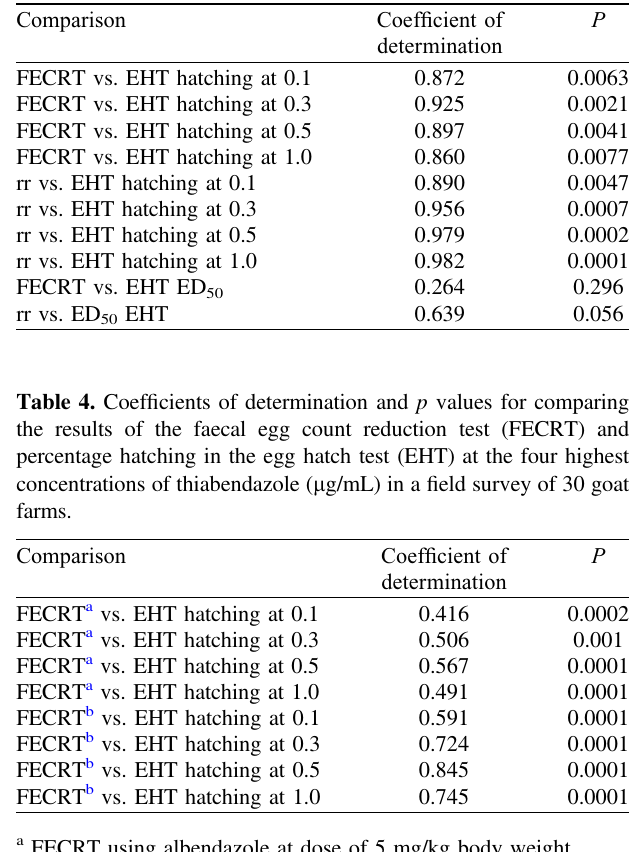
FECRT using albendazole at dose of 10 mg/kg body